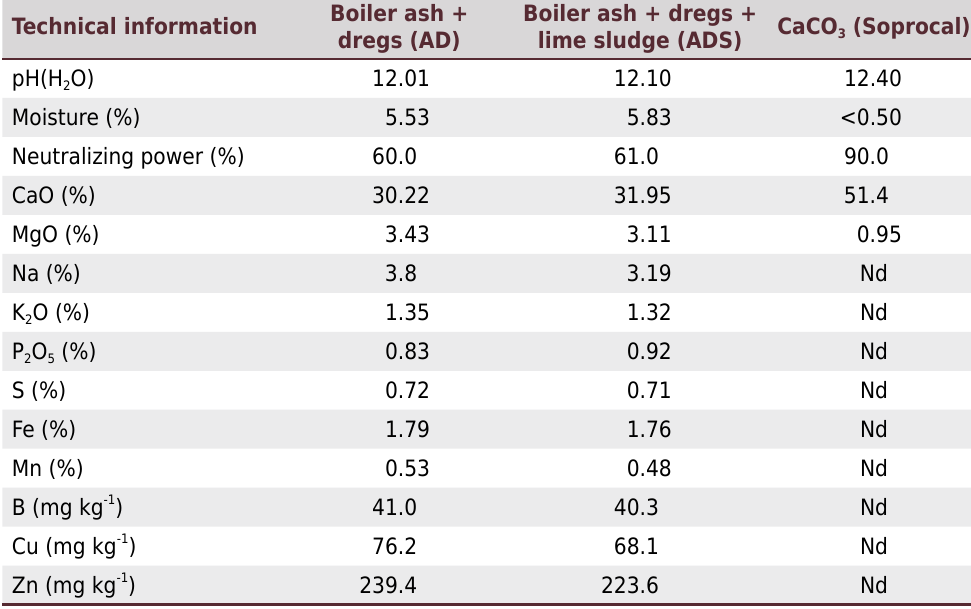
Nd: not determined.